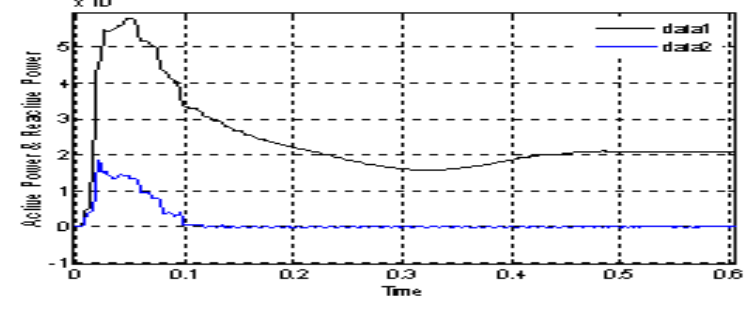
Figure 7. “Active and Reactive power at PCC”.